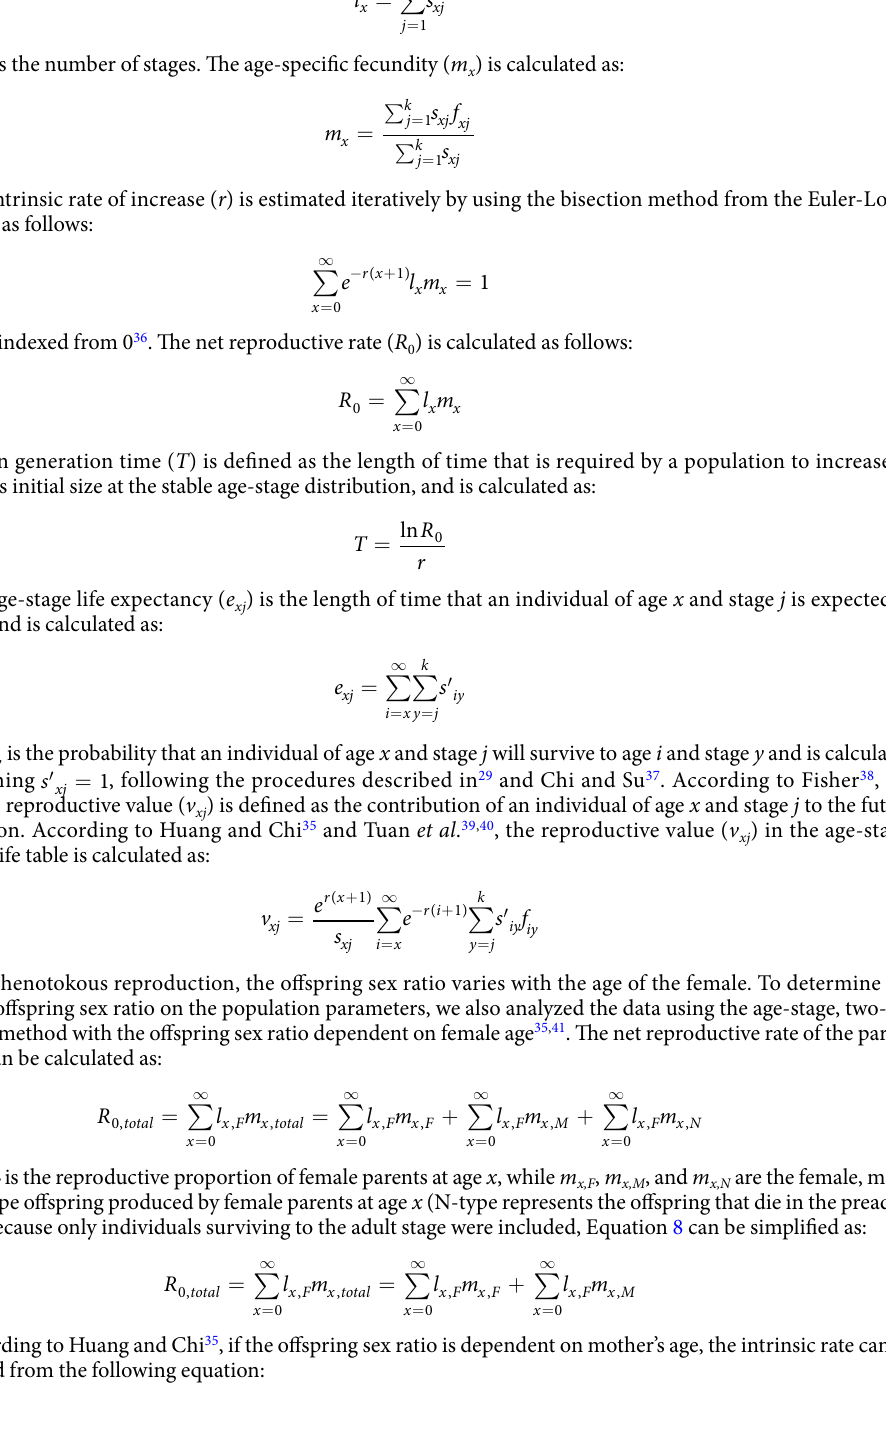
According to Huang and Chi 35 , if the offspring sex ratio is dependent on mother’s age, the intrinsic rate can be estimated from the following